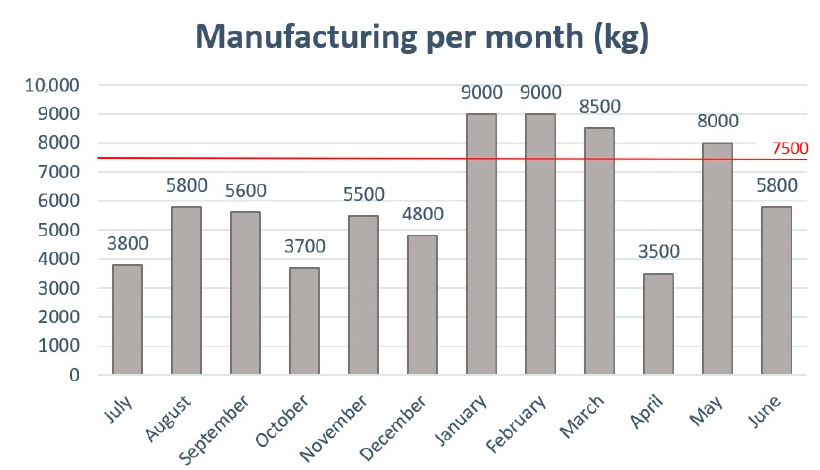
Figure 1. Variation in production volume among the months.